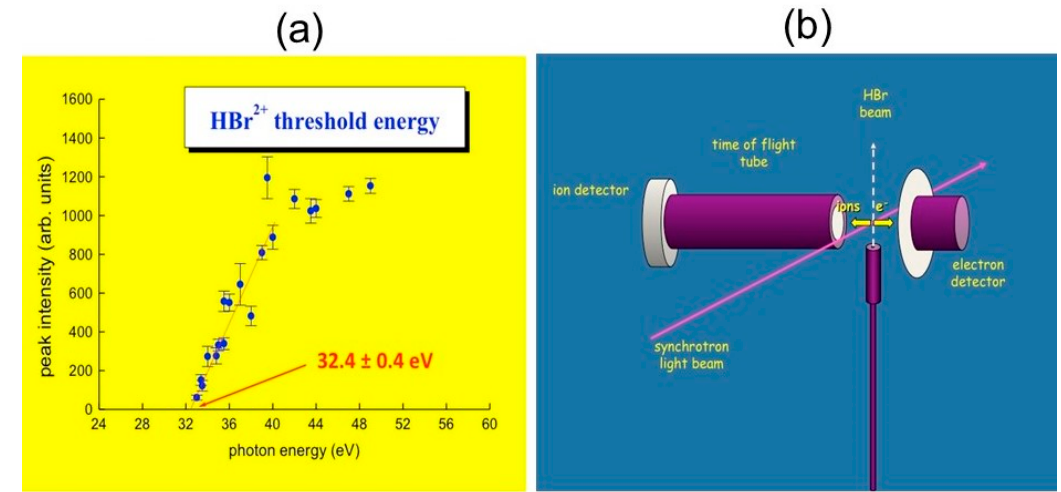
Figure 5. The double photoionization of HBr using synchrotron radiation in the 25–55 eV photon energy range: ( a ) mass spectrometric determination of the threshold energy for the production of HBr 2+ molecular dication; ( b ) a scheme of the set up used in our first experiment at Elettra Synchrotron Facility of Trieste on 2001 [66].